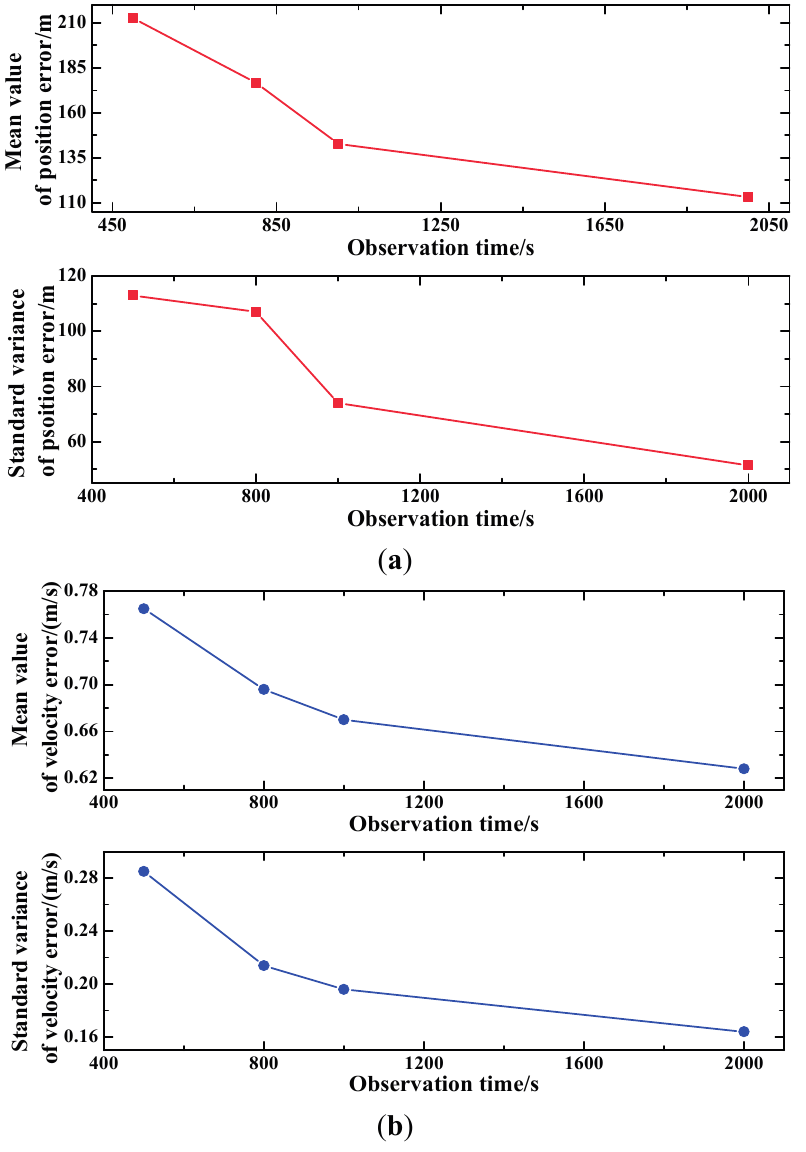
Figure 5. Influence of observation interval on filtering results. ( a ) Mean and standard variance of position error under different observation intervals; ( b ) Mean and standard variance of velocity error under different observation